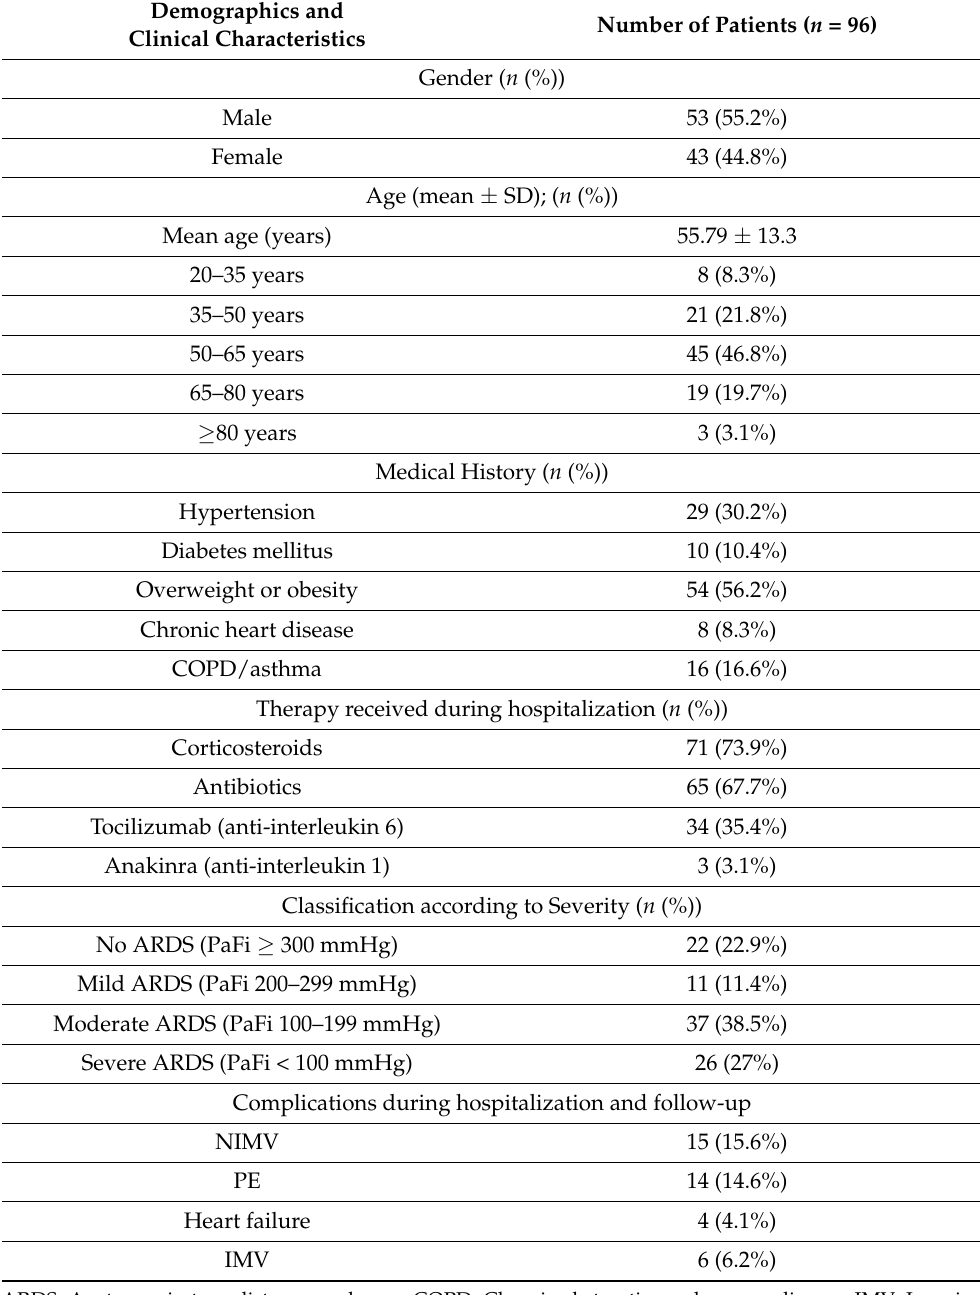
Table 1. Demographics, clinical characteristics and ultrasound severity classification of patients